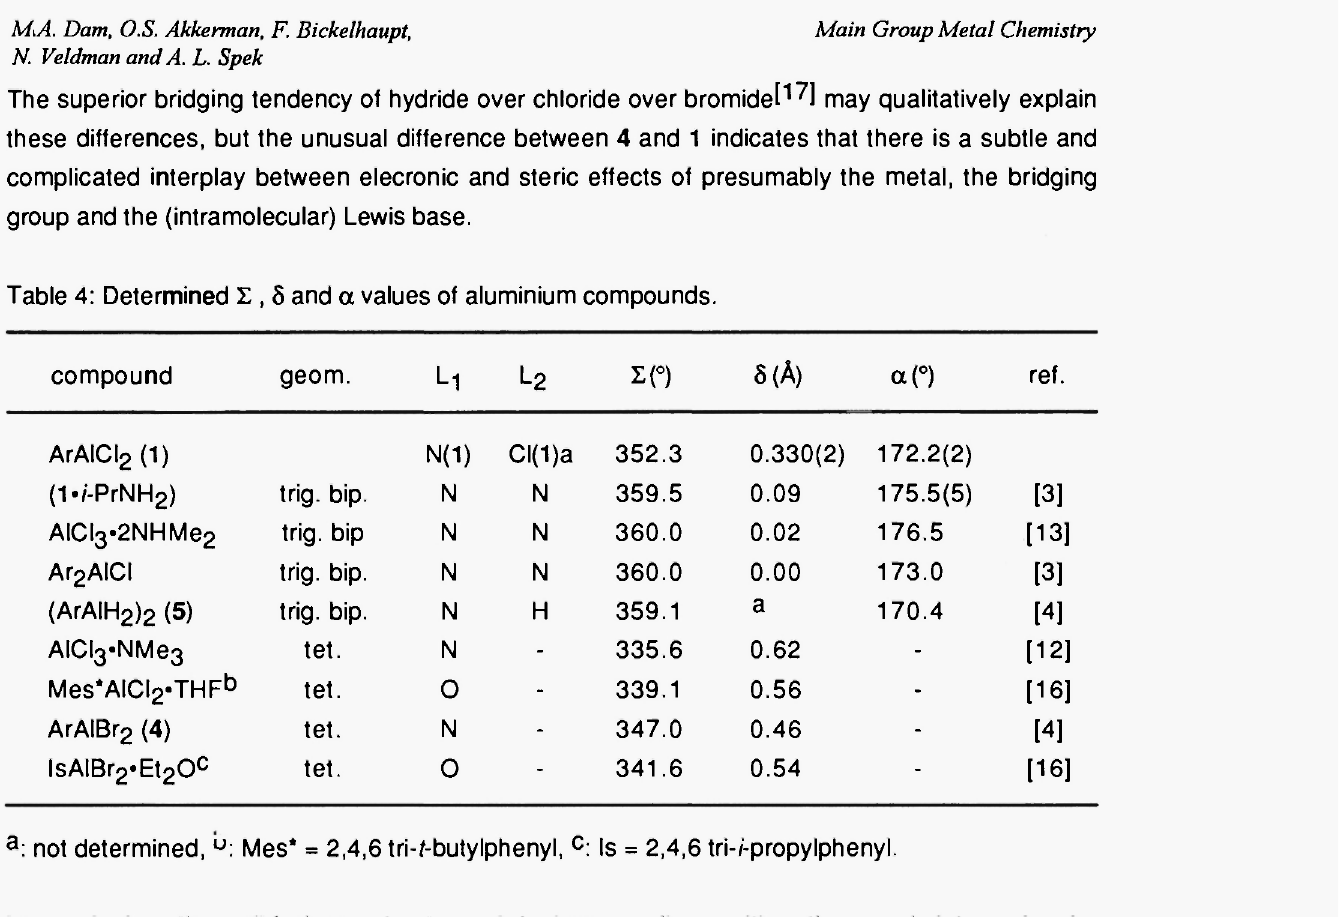
Table 4: Determined Σ , δ and α values of aluminium compounds.